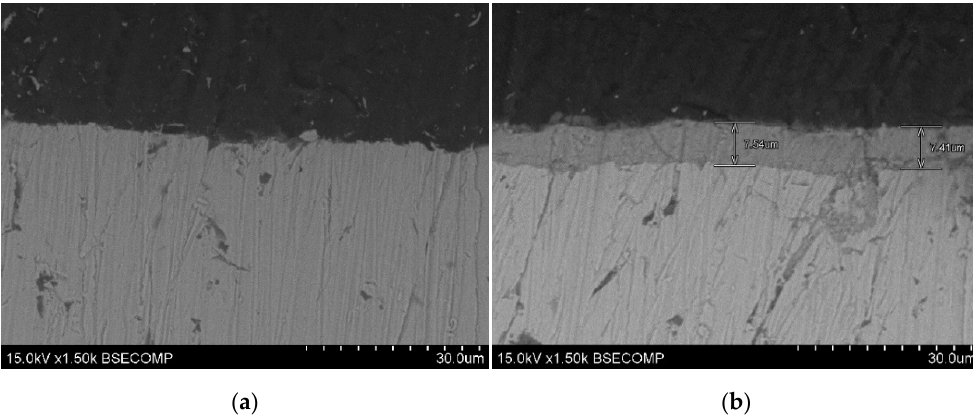
Figure 13. SEM cross-section micrographs of uncoated steel before ( a ) and after ( b ) 25 heat treatment cycles. For the coated samples, the highest intensity peak was attributed to the bonding layer of NiCr at 2 θ = 44.3°. By comparing it with the α -Al 2 O 3 and γ -Al 2 O 3 phase peaks at 2 θ = 43.5° and 45.9°, respectively, it can be stated that the coating thickness remained similar.